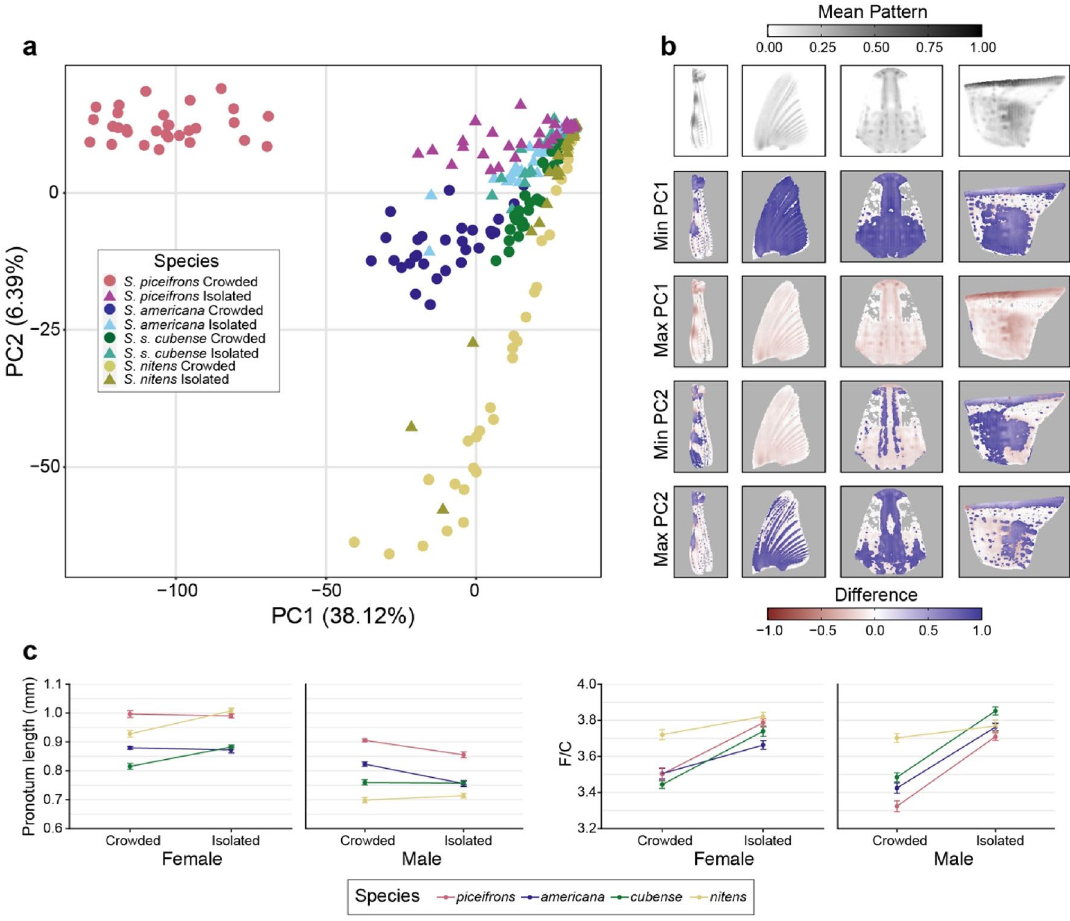
Figure 2. Locust and non-swarming grasshopper species all exhibit morphological responses to rearing density, but they vary among species. ( a ) Plot showing the results of a PCA analysis of the black patterns in four different tissues (hind femur, wing pad, frontal side of the head, and lateral side of the pronotum) for crowd-reared and isolated-reared nymphs of piceifrons , americana , cubense and nitens . Black patterns were detected for each body region separately using the patternize package in R 55 and were converted to specimen- and body region-specific matrices of pixel coordinates associated with a binary depiction of the presence or absence of black colour, and the variance–covariance matrix obtained from these binary matrices was used for a PCA. ( b ) Plots showing the differences in black patterns compared to the average, associated with the minimum and maximum values of each principal component. The first row shows the average black pattern for each measured body region (hind femur, wing pad, frontal side of the head, lateral side of the pronotum), with darker patterns representing spots where a high proportion of individuals had a black pattern. Plots on the lower rows show the difference in the black pattern between this average, and the maximal or minimal value of either PC1 or PC2, with bright blue signifying patterns that are not often found in the average, and bright red indicating the absence of pattern usually found in the average. ( c ) Plots showing the mean pronotum length and F/C ratio for females and males of crowd-reared and isolated-reared specimens of piceifrons, americana, cubense , and nitens . Error bars show the standard error of